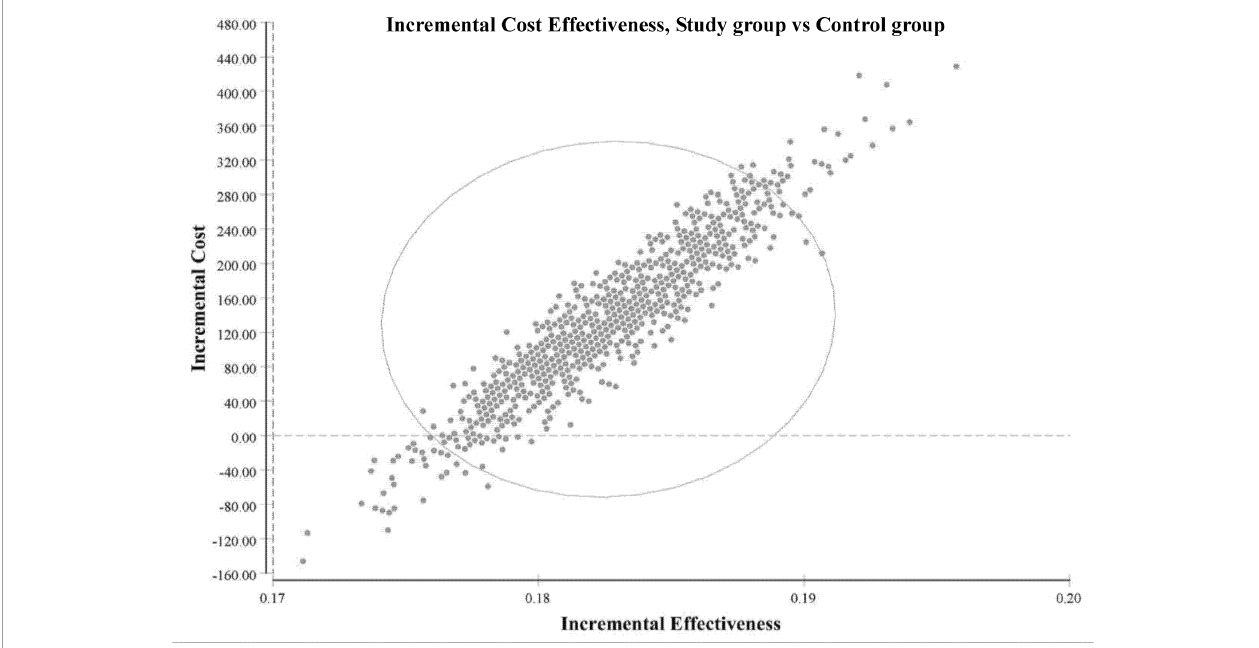
FIGURE 4 | Incremental cost-effectiveness (study group vs. control group). Scatter plots of incremental effectiveness (quality-adjusted life-years) versus incremental costs from 1,000 resamplings in the probabilistic sensitivity analysis with variation limited to cost and effectiveness assumptions and with transition-probabilities constant. This probabilistic sensitivity analysis demonstrated that the study group had a 100% probability of achieving cost-effectiveness relative to the control group in patients with metastatic colorectal cancer. Each plotted point is the result of an incremental cost divided by incremental quality-adjusted life-years. The elliptic circle represents the 95% con fi dence